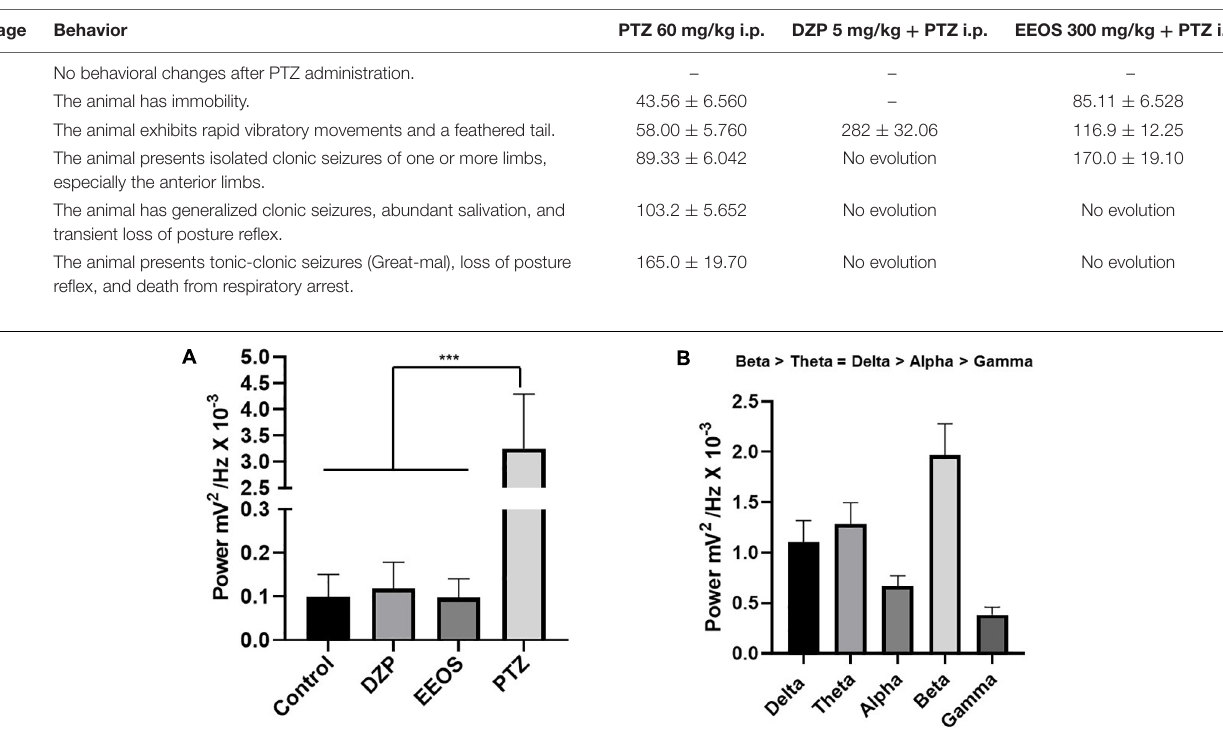
FIGURE 2 | Average power in control electrocorticographic (ECoG) traces, DZP, extract of Euterpe oleracea stones (EEOS), and pentylenetetrazol (PTZ) (A) , and average power of brainwaves during convulsions caused by PTZ (B) . Different letters in columns show significant differences after ANOVA followed by the Tukey’s test (*** p < 0.0001, n =